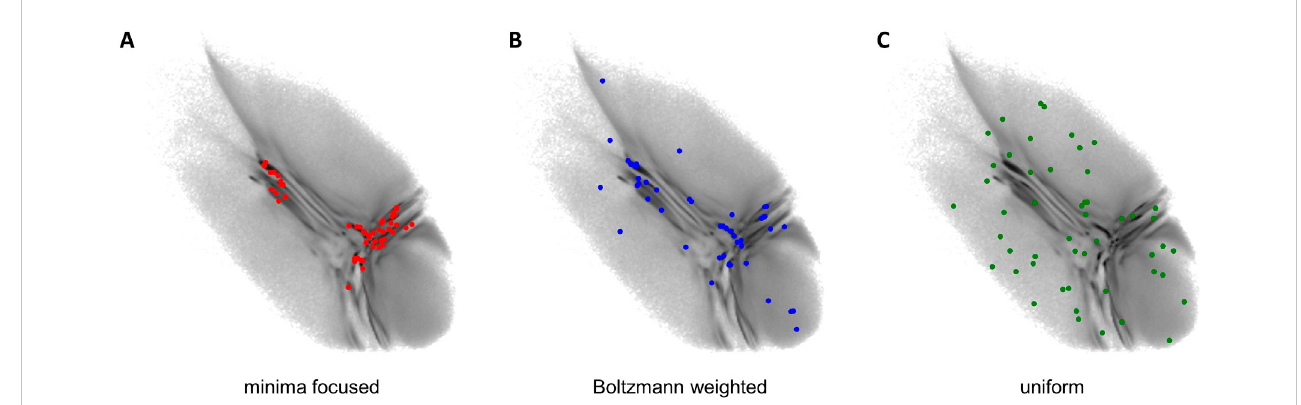
FIGURE 2 Seeding strategies used in this paper: (A) minima focused (red points), (B) Boltzmann weighted (blue points), (C) uniform (green points). Each seeding consists of 50 back-mapped conformations. Their projections are shown on the original CG landscape (gray gradient, same as in Figure 1 (A)